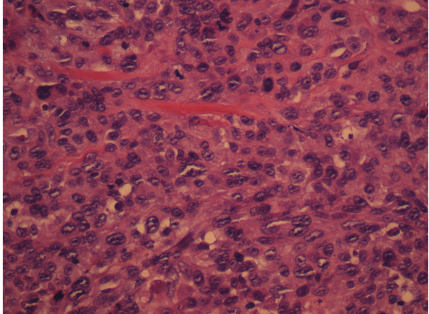
Figure 3: Undifferentiated cells H&E × 200.